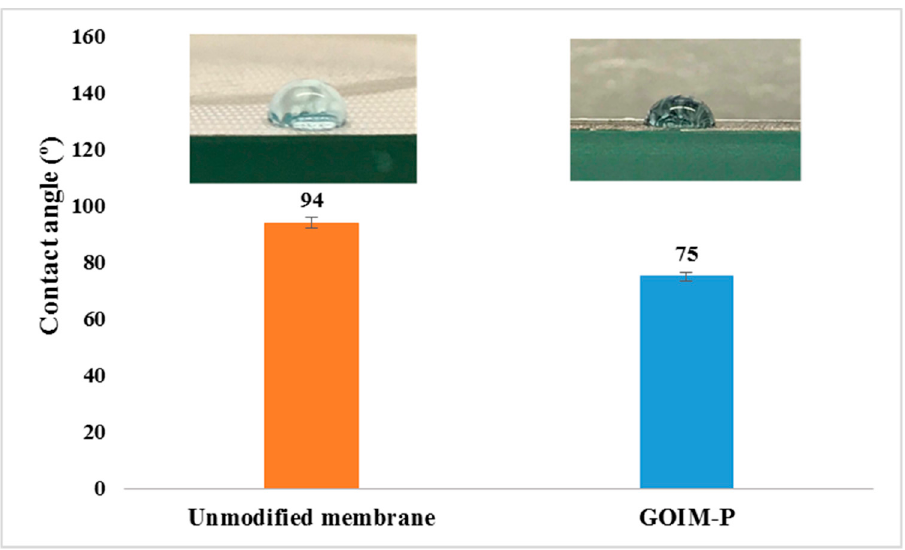
Figure 5. Contact angle and photographs of permeate side of unmodified and GOIM-P.